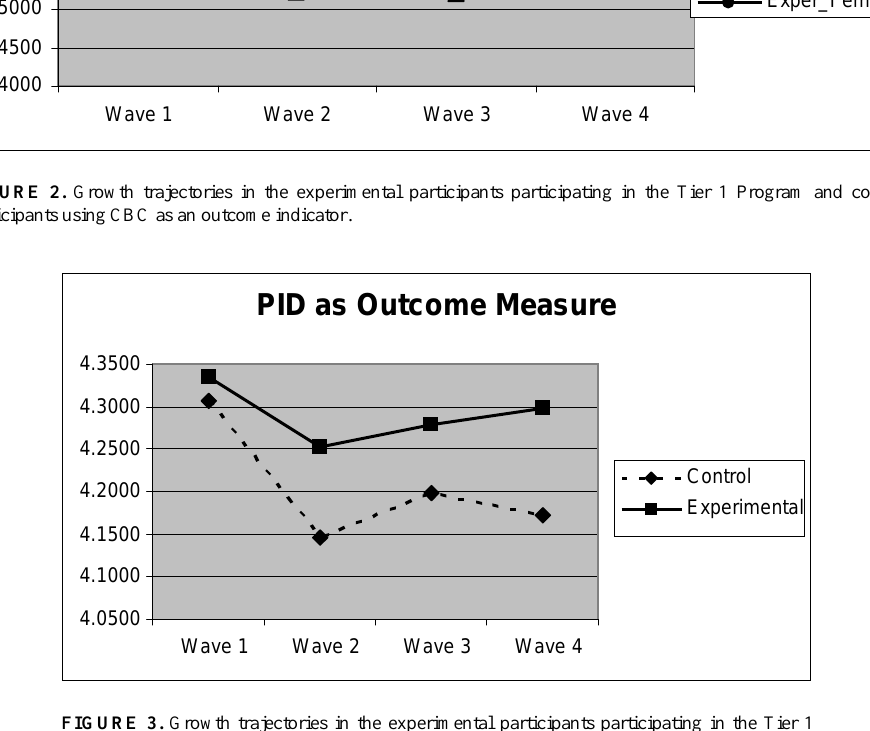
FIGURE 3. Growth trajectories in the experimental participants participating in the Tier 1 Program and control participants using PID as an outcome indicator.